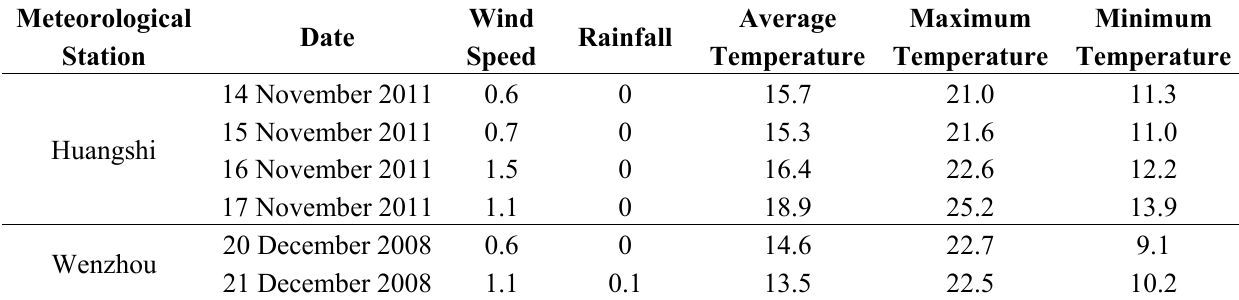
Table 4. Observed meteorological data during date